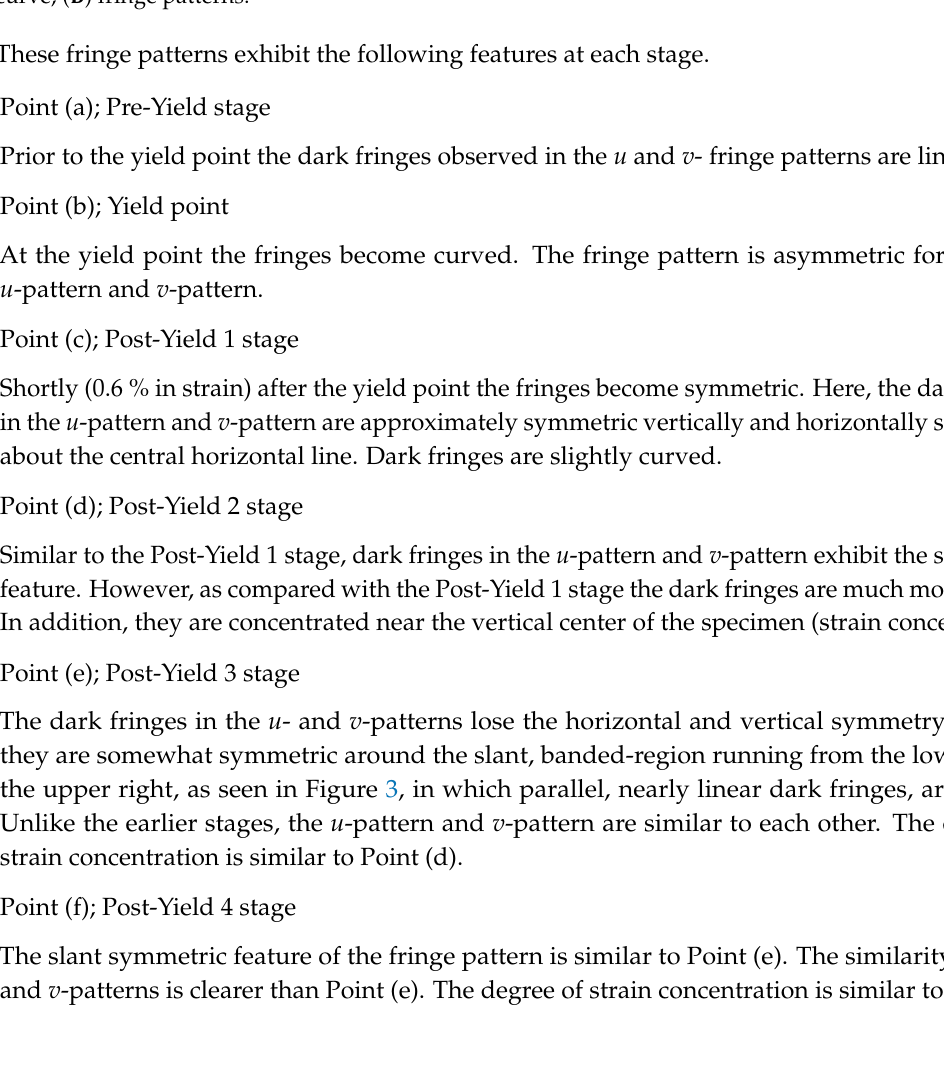
Figure 3. Evolution of fringe patterns observed in aluminum alloy AA7075 plate specimen. ( A ) loading curve, ( B ) fringe